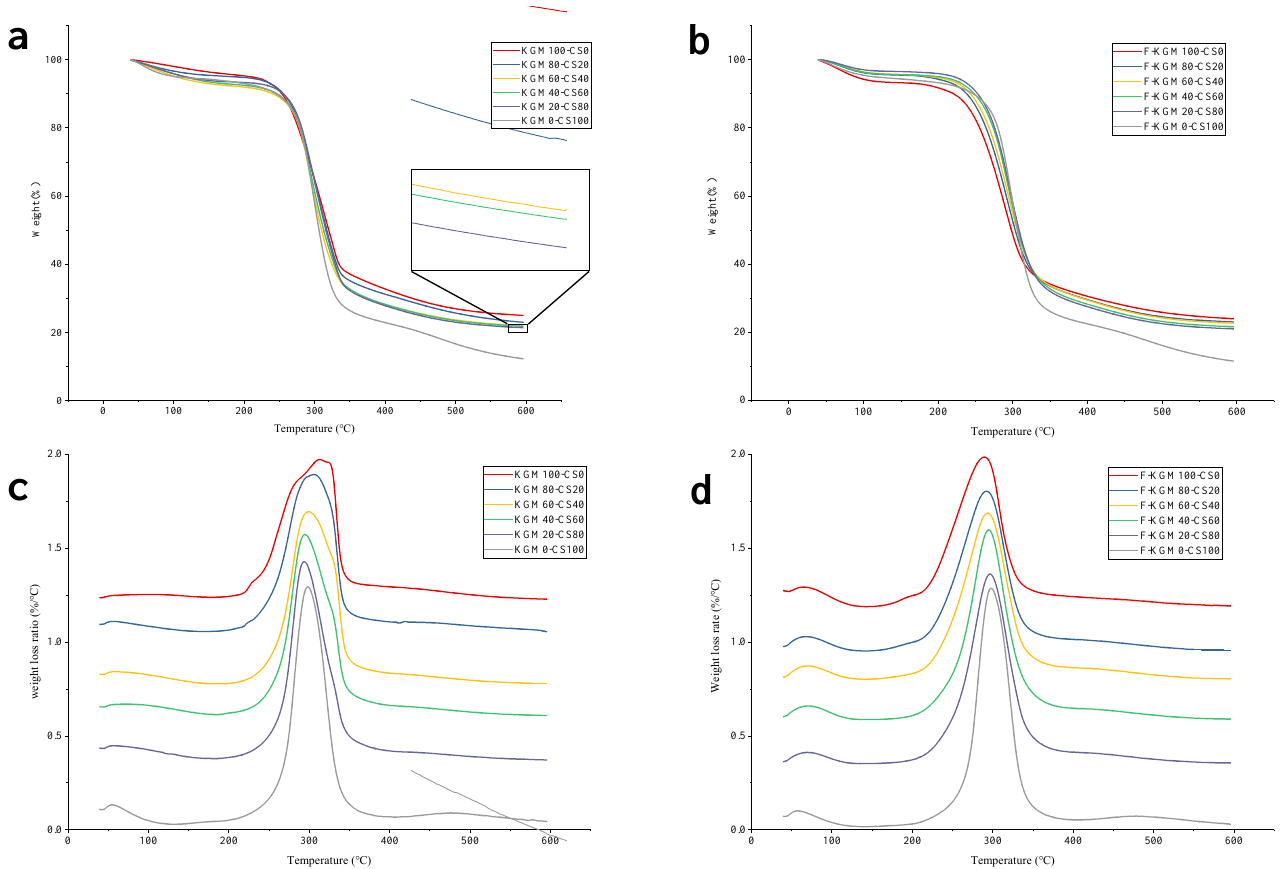
Figure 2. Thermal gravimetric graph of the composite gels with different KGM/starch ratios. The weight loss of KGM–CS ( a ) and F–KGM–CS ( b ) gels. The weight loss rate of KGM–CS ( c ) and F–KGM–CS ( d ) gels.